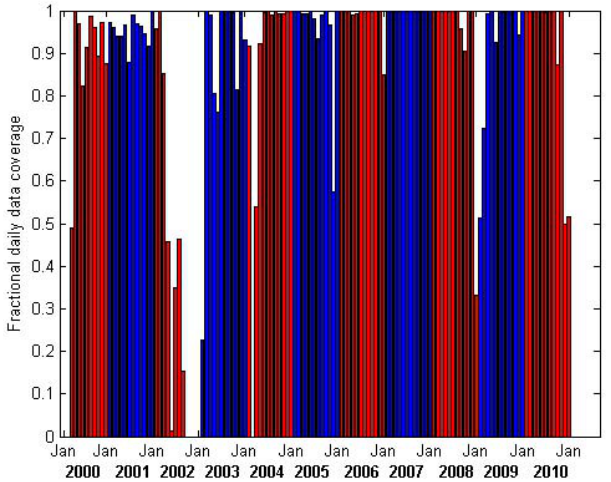
Fig. 1. Data coverage as fraction per month for the investigated pe- riod, March 2000–March 2010. Data are shown as percent of daily averages. Red bars correspond to even years, blue bars correspond to odd.